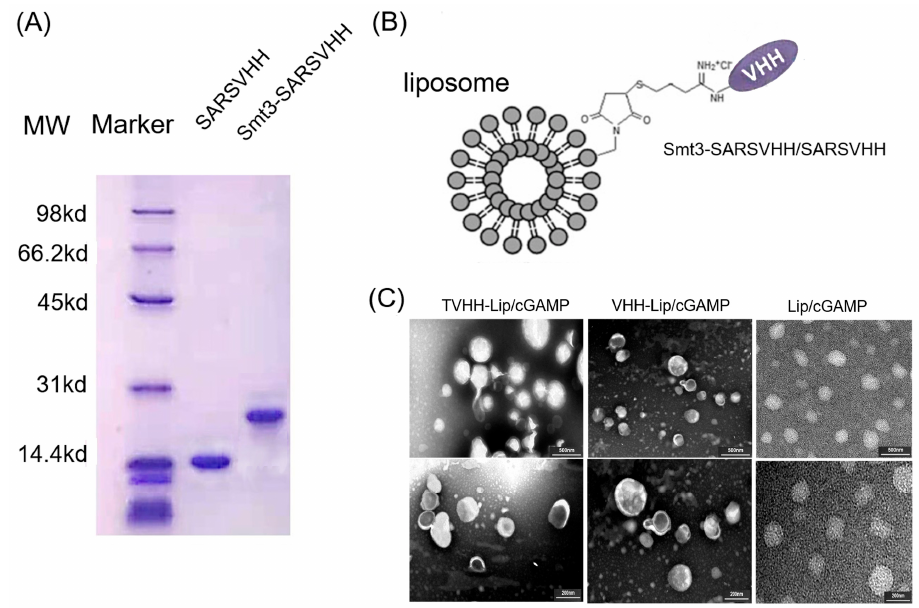
Figure 1. ( A )The purified nanobodies SARSVHH and Smt3-SARSVHH. ( B ) The structure of TVHH- Lip/cGAMP and VHH-Lip/cGAMP. ( C ) The TEM revealed cGAMP-loaded liposomes with a uniform spherical shape (upper lane scale bars: 500 nm, lower lane scale bars: 200 nm). The structure of TVHH-Lip/cGAMP and VHH-Lip/cGAMP is shown in Figure 1B. The drug encapsulation efficiency (EE%), particle size, zeta potential, polydispersity index (PDI) and drug loading efficiency (LE%) are listed in Table 1. Table 1. The characterization of cGAMP-loaded liposomes.